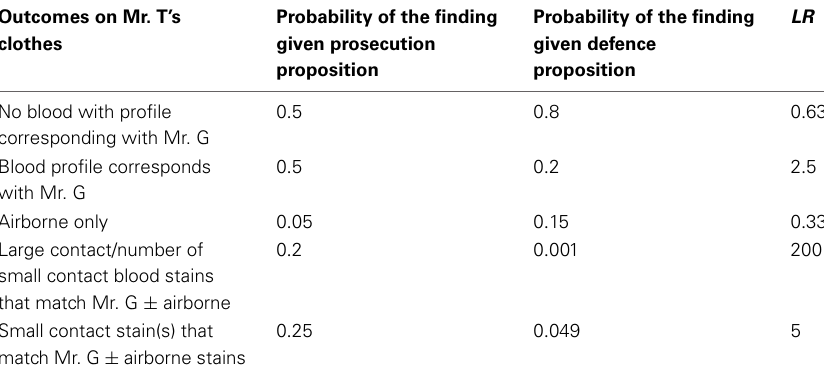
Table 1 | Pre-case assessment. Outcomes on Mr. T’s